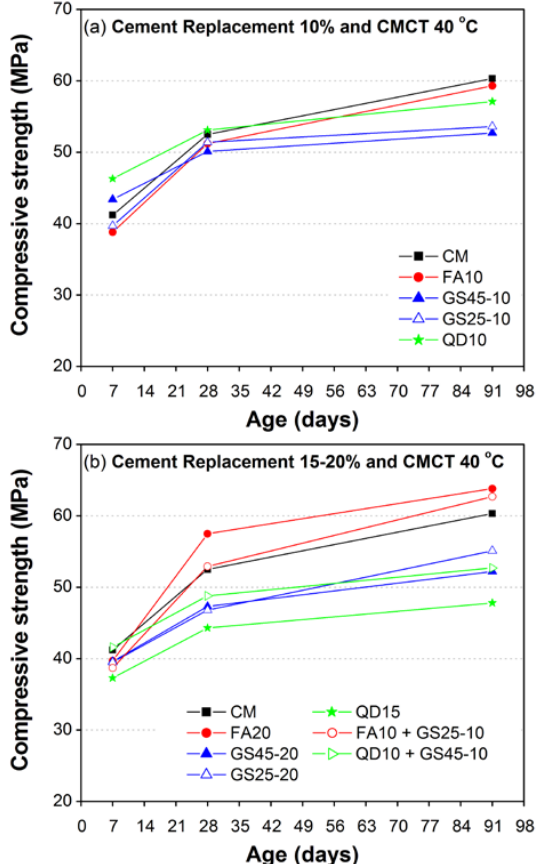
Figure 7. Effect of moderately high curing temperature (40 °C) on compressive strength development of CM and mortar containing GS, QD, and FA as a partial replacement of cement: ( a ) 10%; ( b ) 15–20%.